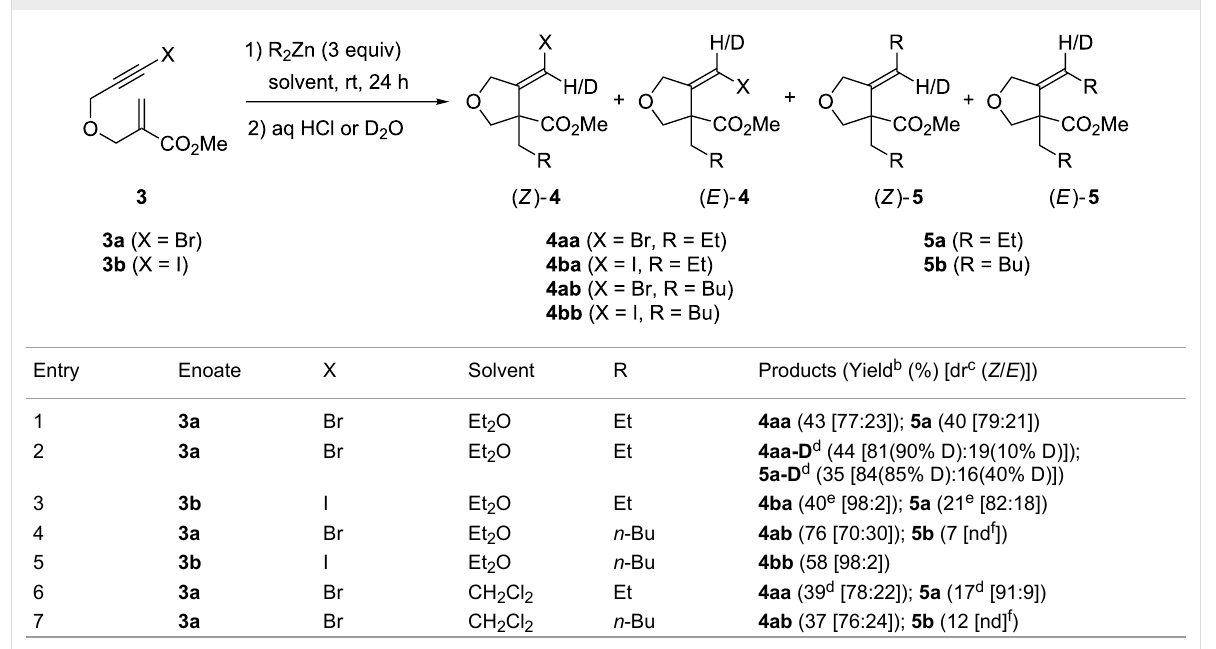
Table 1: 1,4-addition/carbozincation of dialkylzincs with β -(propargyloxy)enoates 3 having pendant haloalkynes in the presence of traces of air. a